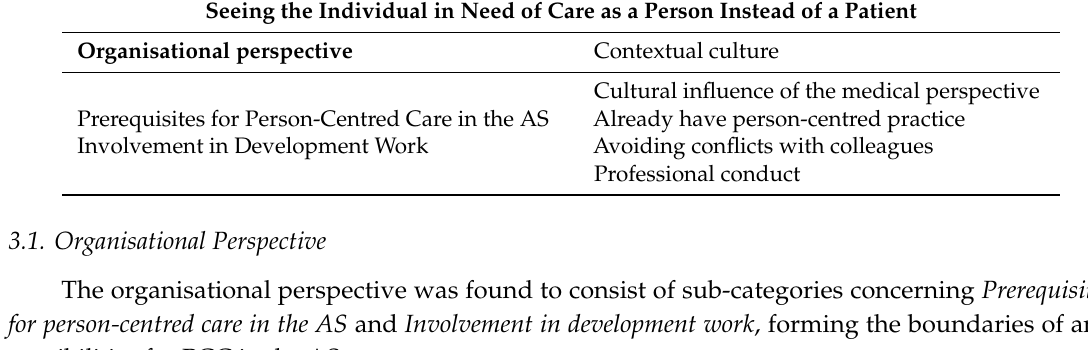
Table 1. Summary of the theme, categories and